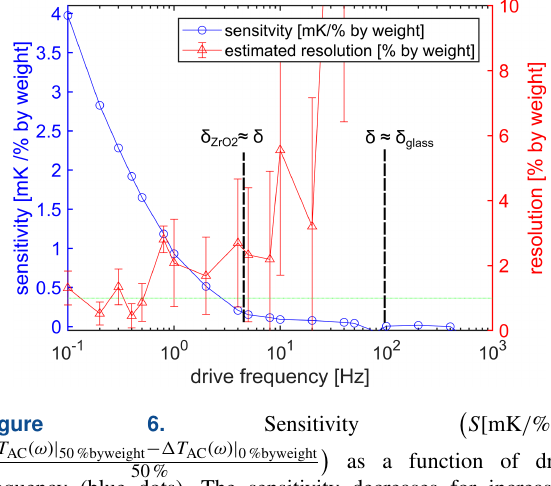
(cid:0) S [ mK / % ] = Figure 6. Sensitivity (cid:49)T AC ( ω ) | 50%byweight − (cid:49)T AC ( ω ) | 0%byweight (cid:1) as a function of drive 50% frequency (blue dots). The sensitivity decreases for increasing drive frequency. The steepest decrease takes place if the frequency is smaller than 5Hz. For higher frequencies, the thermal wave does not penetrate the zirconium oxide and a low sensitivity is expected. Estimated resolution ( R = δ ( (cid:49)T AC ) , where δ ( (cid:49)T AC ) is S the measurement uncertainty for a given frequency) as a function of drive frequency (red triangle). The resolution is 1% by weight if the frequency is lower than 0 .